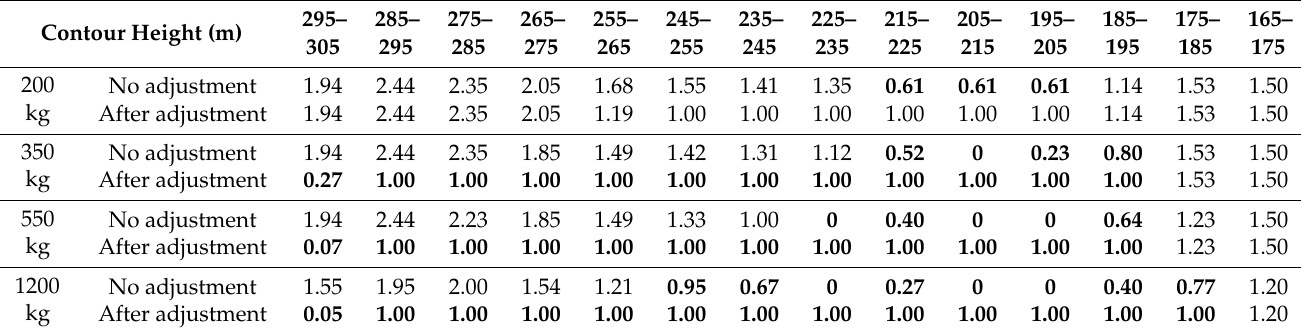
Table 8. Effects of underwater contact explosion on antisliding stability safety factor of the entire dam.